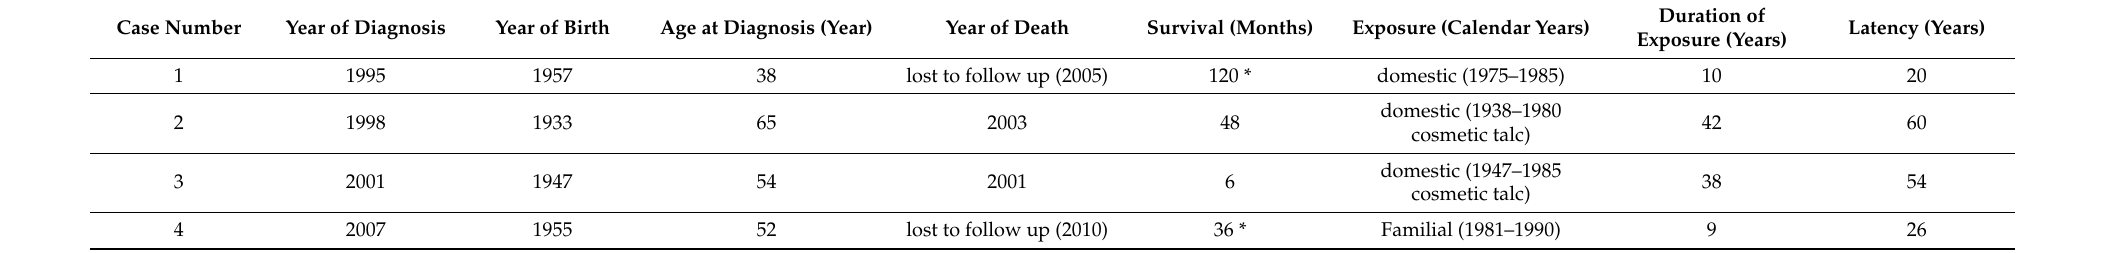
Table 1. Main clinical features and exposure history of the four patients affected by ovarian mesothelioma.